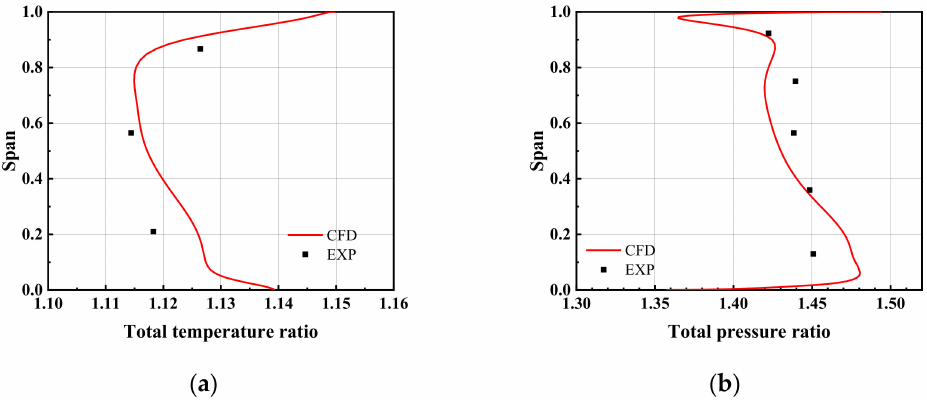
Figure 5. Spanwise distributions of total temperature ratio and total pressure ratio: ( a ) total tempera- ture ratio; ( b ) total pressure ratio.